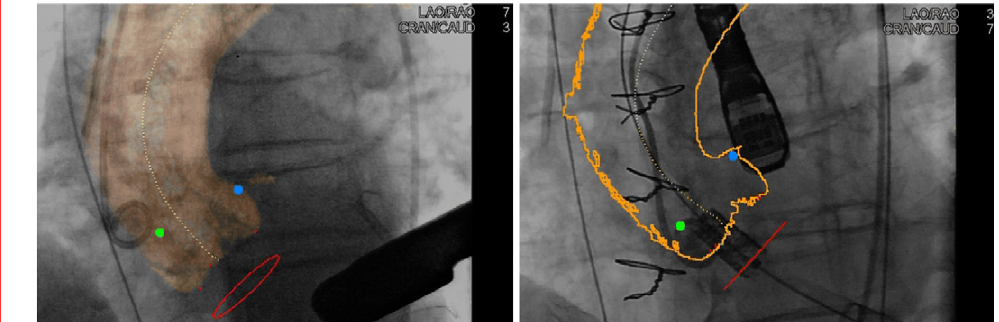
Figure. 6 Interoperative fusion of 3D information from DynaCT with 2D